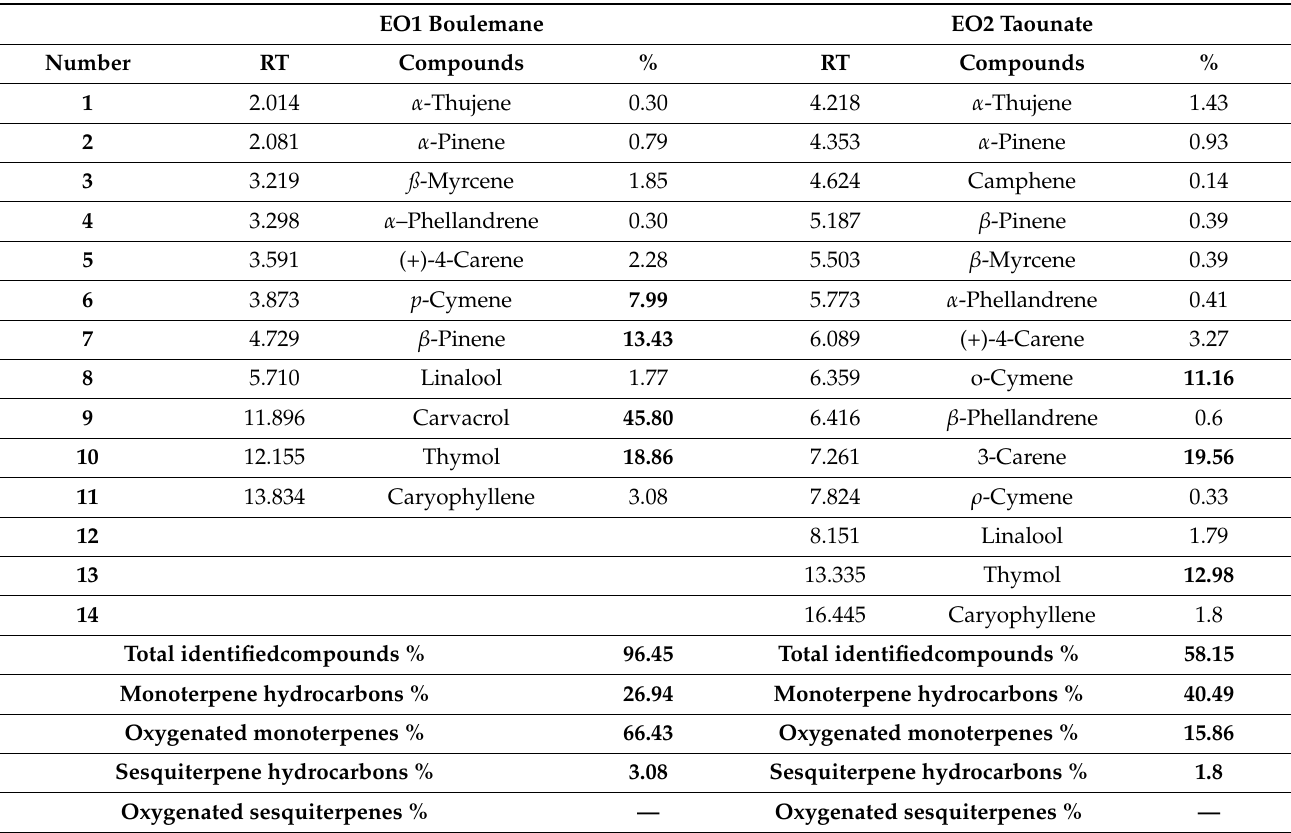
Table 1. Chemical composition of O. compactum essential